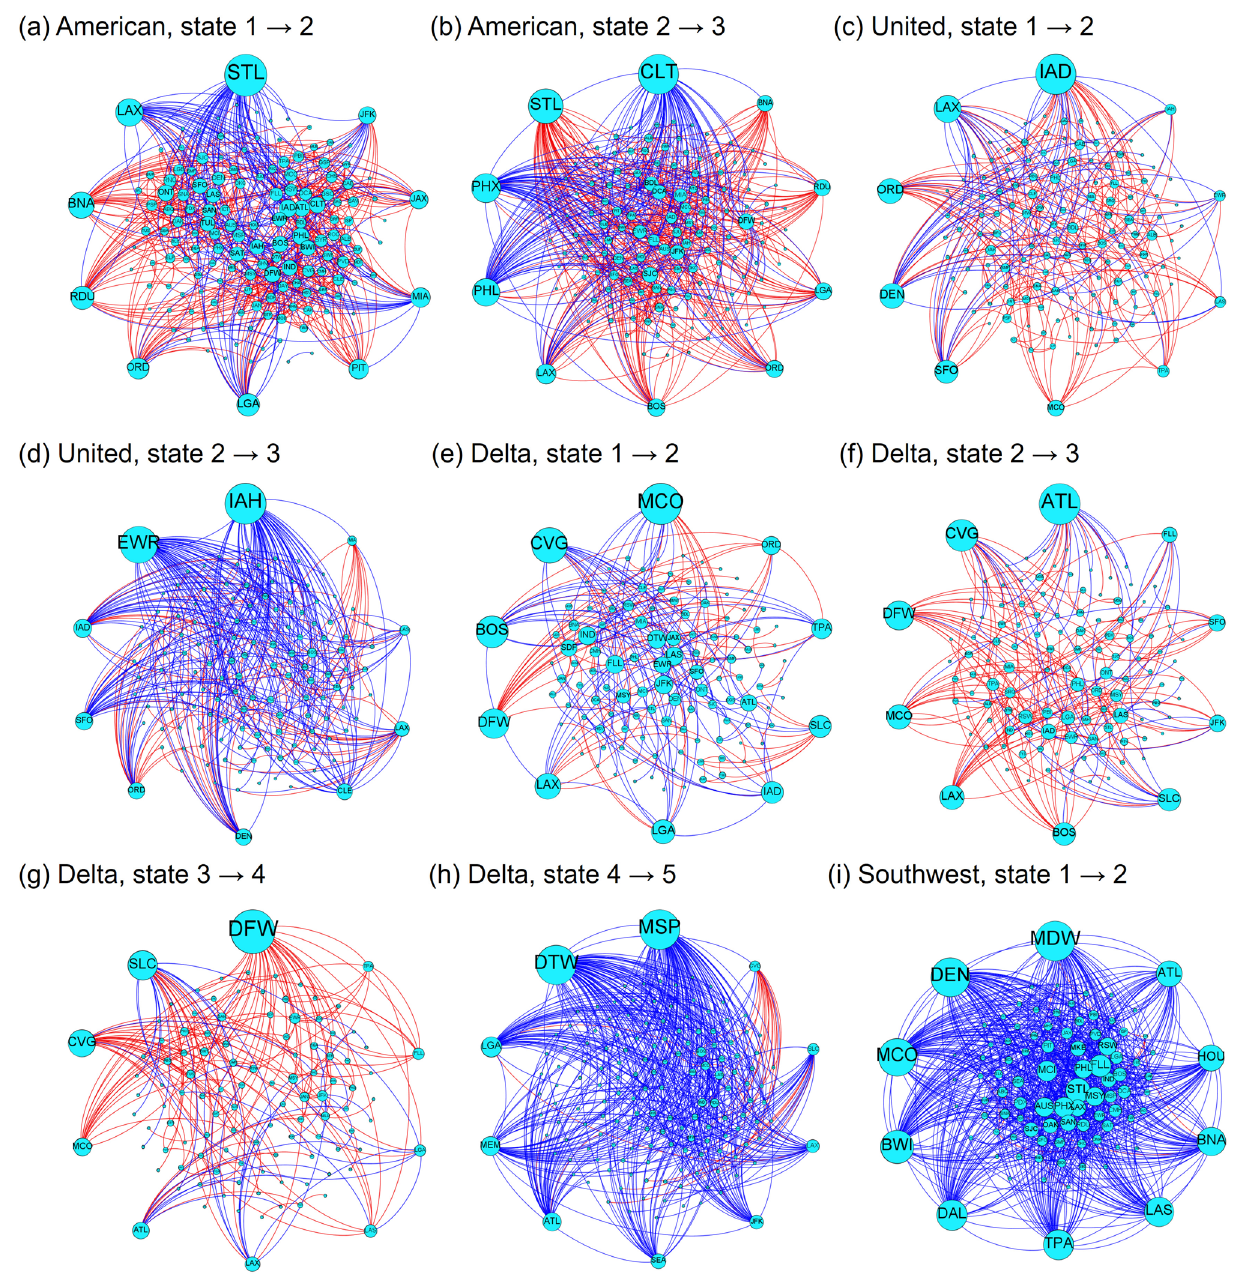
Figure 7. Deleted edges (shown in red) and added edges (shown in blue) for each pair of the consecutive states. In each panel, we placed 10 nodes with the largest number of added and deleted edges in total in the peripheral part of the